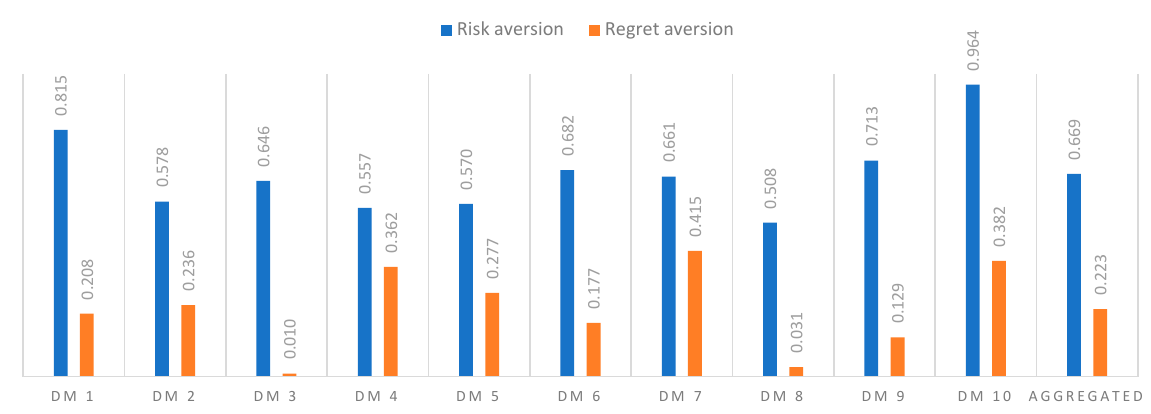
Figure 4. Psychological behavior coefficients of decision-makers.